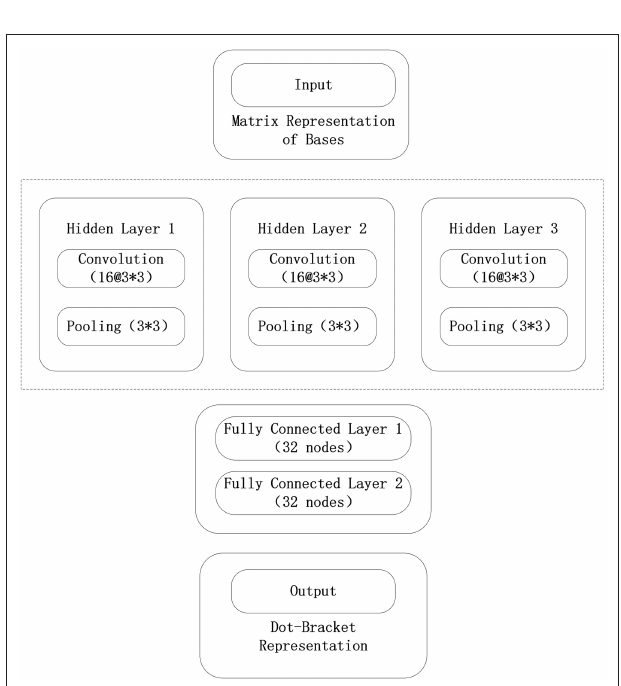
FIGURE 5 | Convolutional neural network structure in the 5sRNA